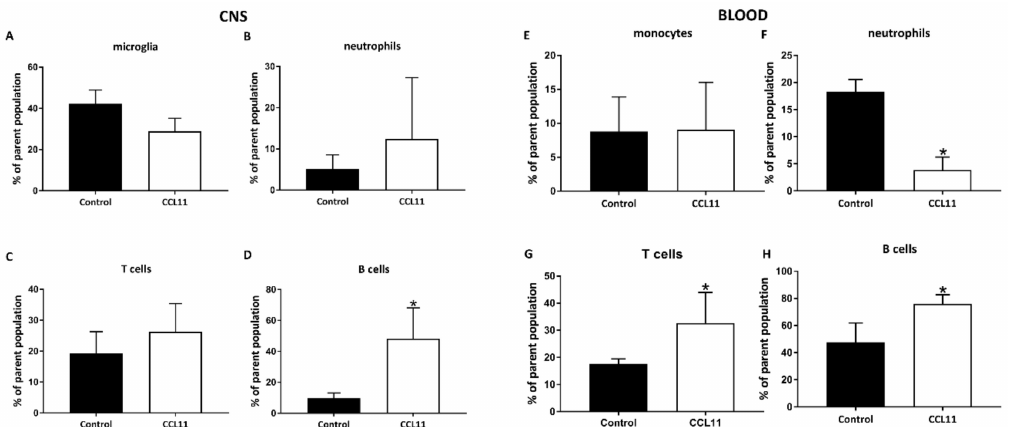
Figure 7. CCL11 modifies the subacute central and systemic immune response in post-stroke adult mice. C57BL6 male mice with an age of six month were subjected to cerebral ischemia for 45 min followed by reperfusion for 7 days. At the beginning of the reperfusion, mice received intraperitoneal injections of either 10 µ g / kg bodyweight of CCL11 or 100 µ L of PBS as control and daily on the seven consecutive days after reperfusion. Flow cytometry was analyzed with FlowJo software. ( A – D ) shows the quantitative analysis of adult animals of ( A ) CD45 int cells, ns p = 0.057, ( B ) shows Ly6G + cells, ns p = 0.885, ( C ) displays CD3 + cells, ns p = 0.342 ( D ) shows CD19 + cells, *significantly di ff erent from the corresponding control, p = 0.028, as measured in the CNS. In ( E – H ) the quantitative analysis of the adult animals of ( E ) CD45 int cells was performed, ns p = 0.885 ( F ) depicts Ly6G + cells, *significantly di ff erent from the corresponding control, p = 0.028, ( G ) shows CD3 + cells,*significantly di ff erent from the corresponding control, p = 0.028, ( H ) demonstrates CD19 + cells, *significantly di ff erent from the corresponding control, p = 0.028, as measured in the blood is shown. n = 4 in each group. All data are given as means ±